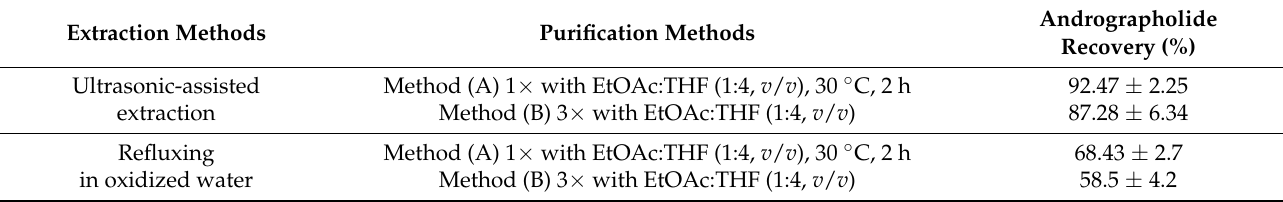
Table 1. Recoveries of the internal standard andrographolide added to G. biloba leaf extracts ob- tained with two extraction and two purification methods.